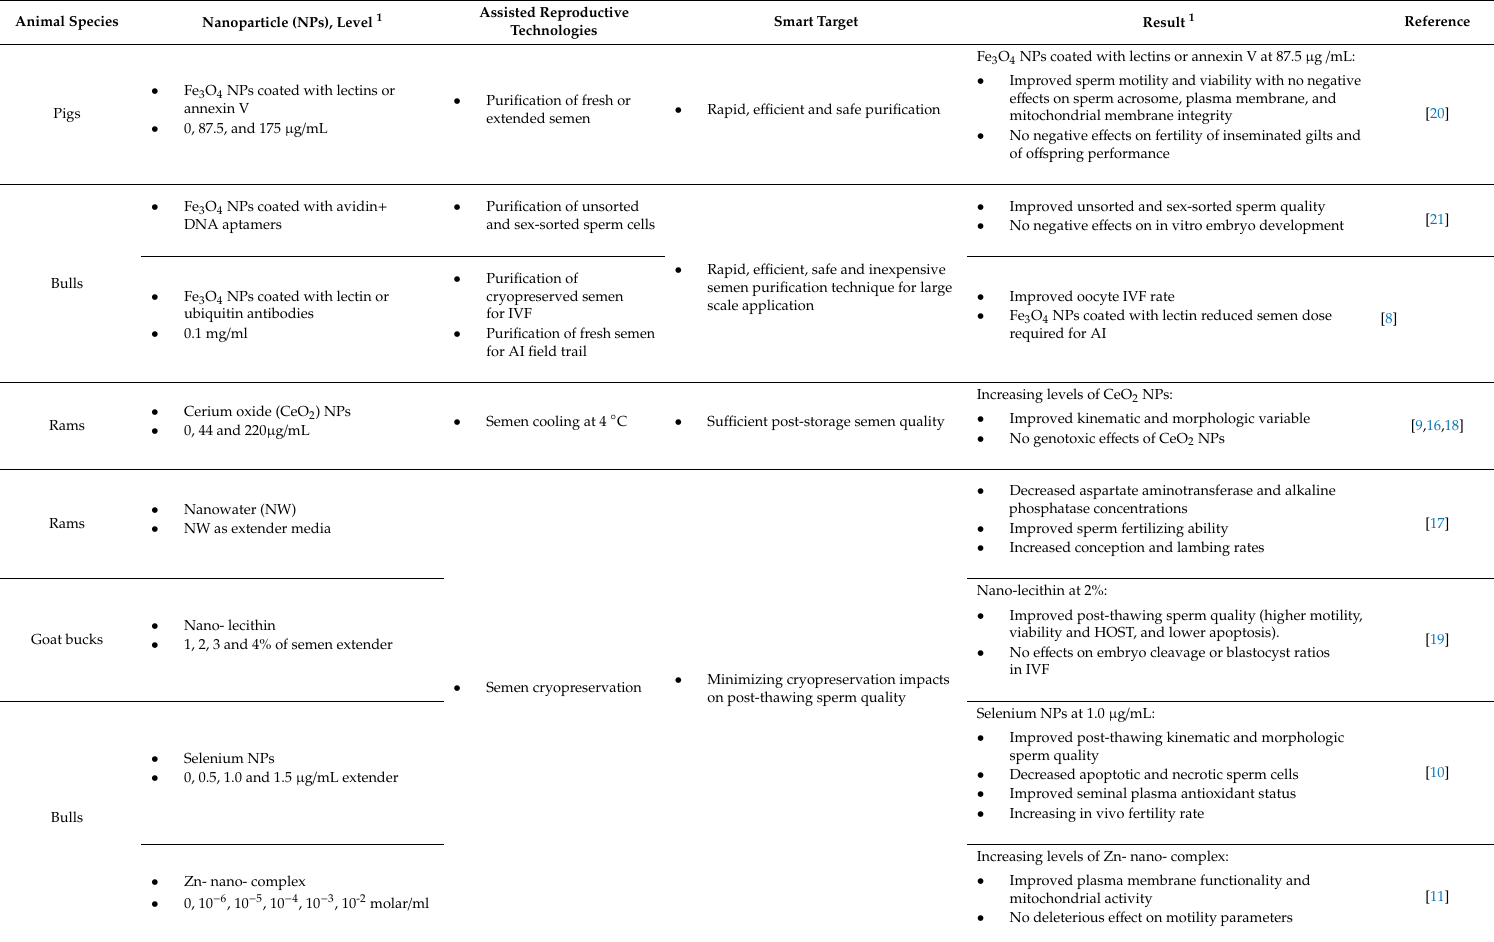
Table 1. Summary of previous research connecting nanotechnology and semen preservation and purification.